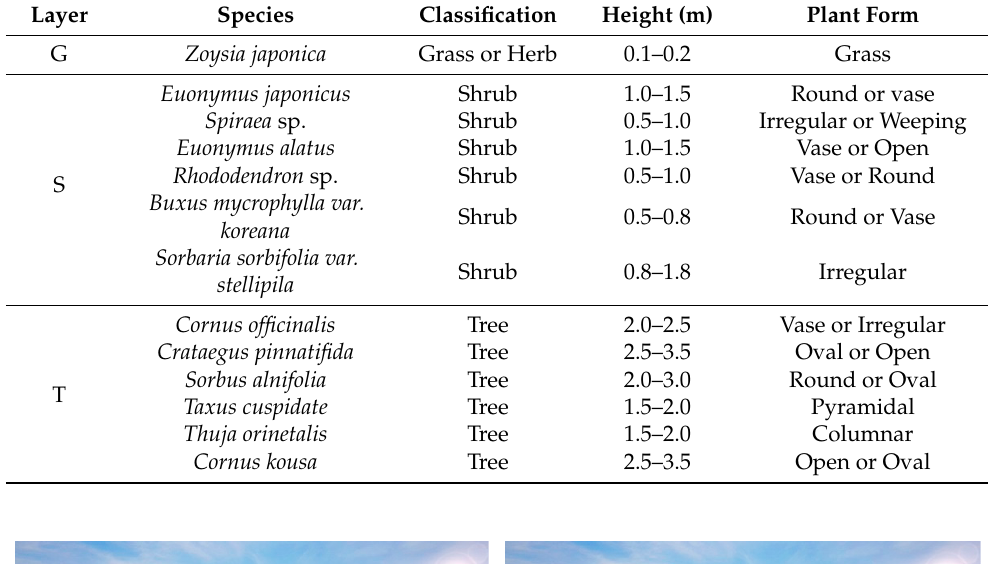
Table 1. Planted species in three vegetation layers; G: grass layer; S: shrub layer; T: tree layer.